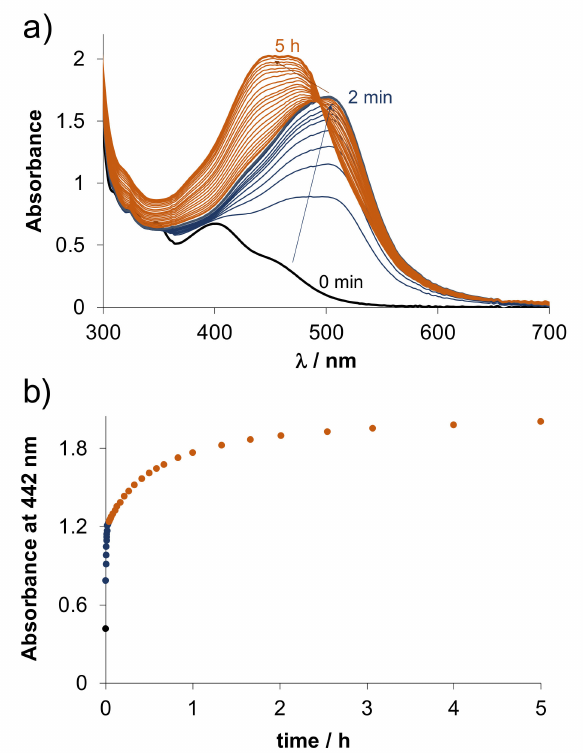
Figure 6. ( a ) Time-dependent UV-vis spectra of the RuCym–HQCl-D-Pro complex in the presence of 2 equiv. phen at pH = 7.40, and ( b ) absorbance changes at 442 nm. (Dark blue color indicates the first process: liberation of p -cymene and coordination of the first phen; orange color indicates the second process: coordination of the second phen.) { c RuCym = c HQCl-D-Pro = 200 µ M; c 1,10-phenantroline = 400 µ M; pH = 7.40 (20 mM phosphate buffer); T = 25.0 ◦ C; (cid:96) = 1